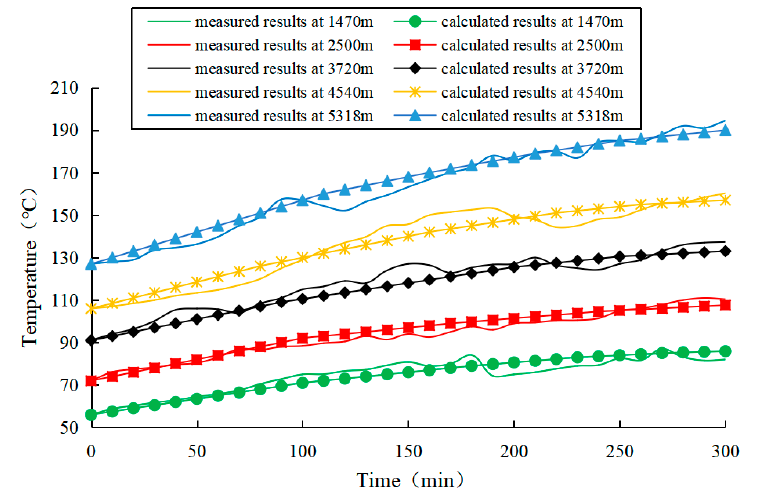
Figure 8. Comparison of calculated temperatures and measured temperatures.